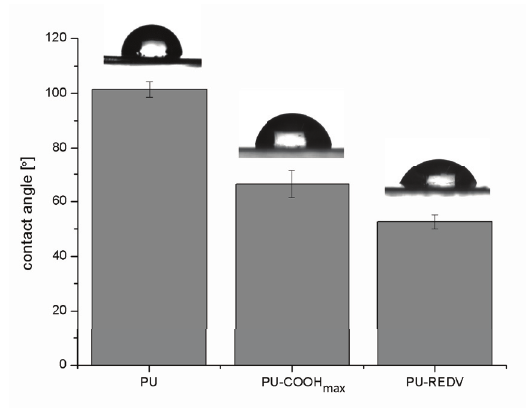
Figure 5: Values of contact angle for non-modifi ed PU and PU aft er subsequent modifi cation steps: aft er AA graft ing (PU-COOH peptide coupling (PU-REDV). MV±SD, n=5.